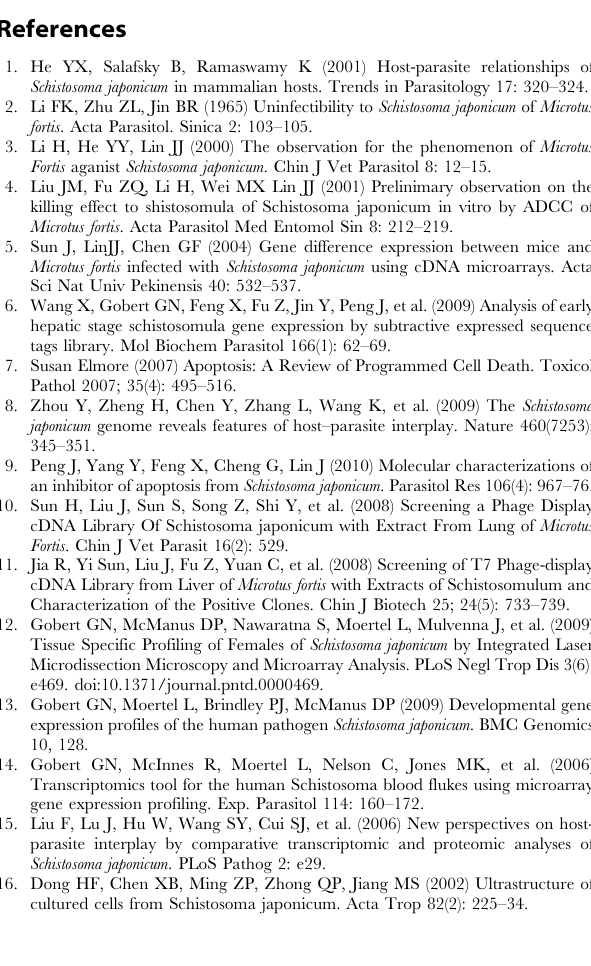
Table S6 A full list of genes, including systematic name, Gene ID and protein homology significantly up and down regulated in schistosomula from Microtus fortis. Figure S1 The apoptosis signal pathway in Homo and S. japonicum (from the S. japonicum genome project database;http://chgc.sh.cn/